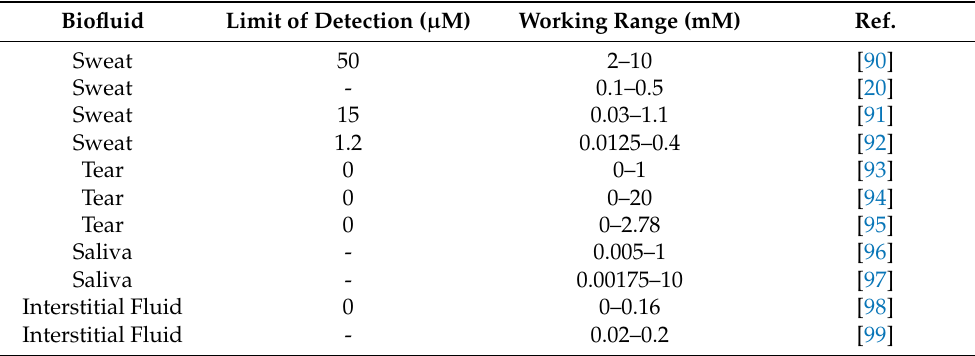
Table 4. List of smartphone-based wearable glucose monitoring